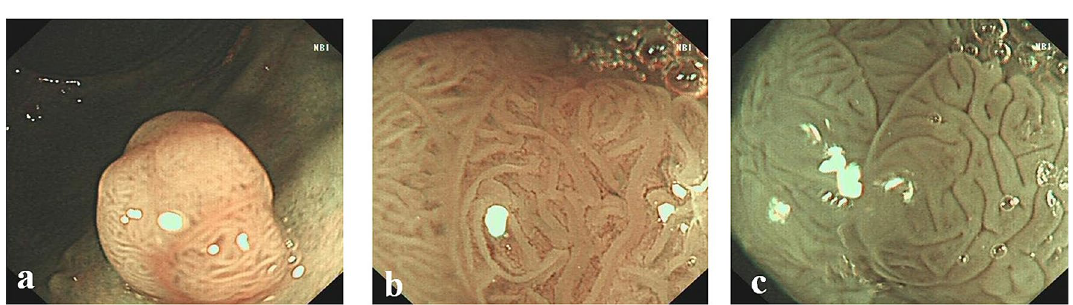
Figure 1. Surface patterns of non-neoplastic polyps viewed by different modalities: ( a ) NBI; ( b ) NBIME; ( c ) AA-NBIME.